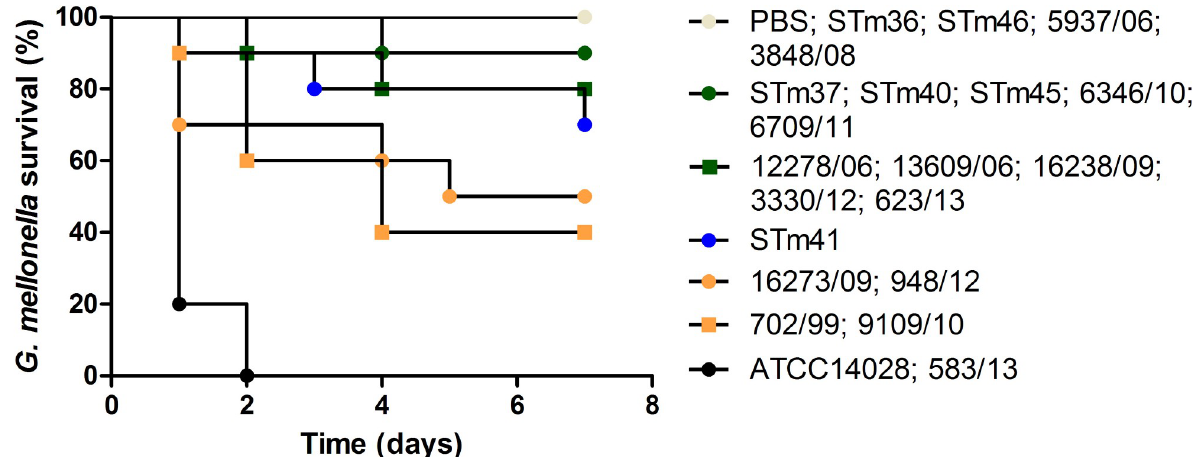
Fig 5. Survival percentages of Galleria mellonella larvae infected with 20 Salmonella Typhimurium isolates from foods in Brazil after seven days.